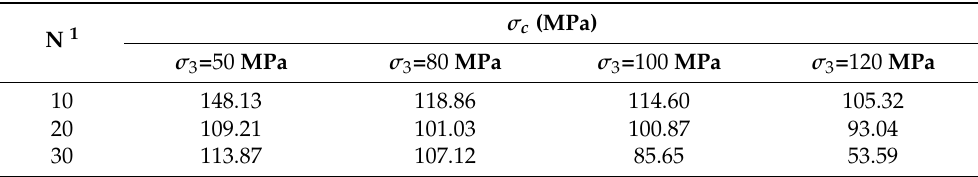
Table 3. The average uniaxial compressive strength of pre-damaged specimens under different damage conditions.